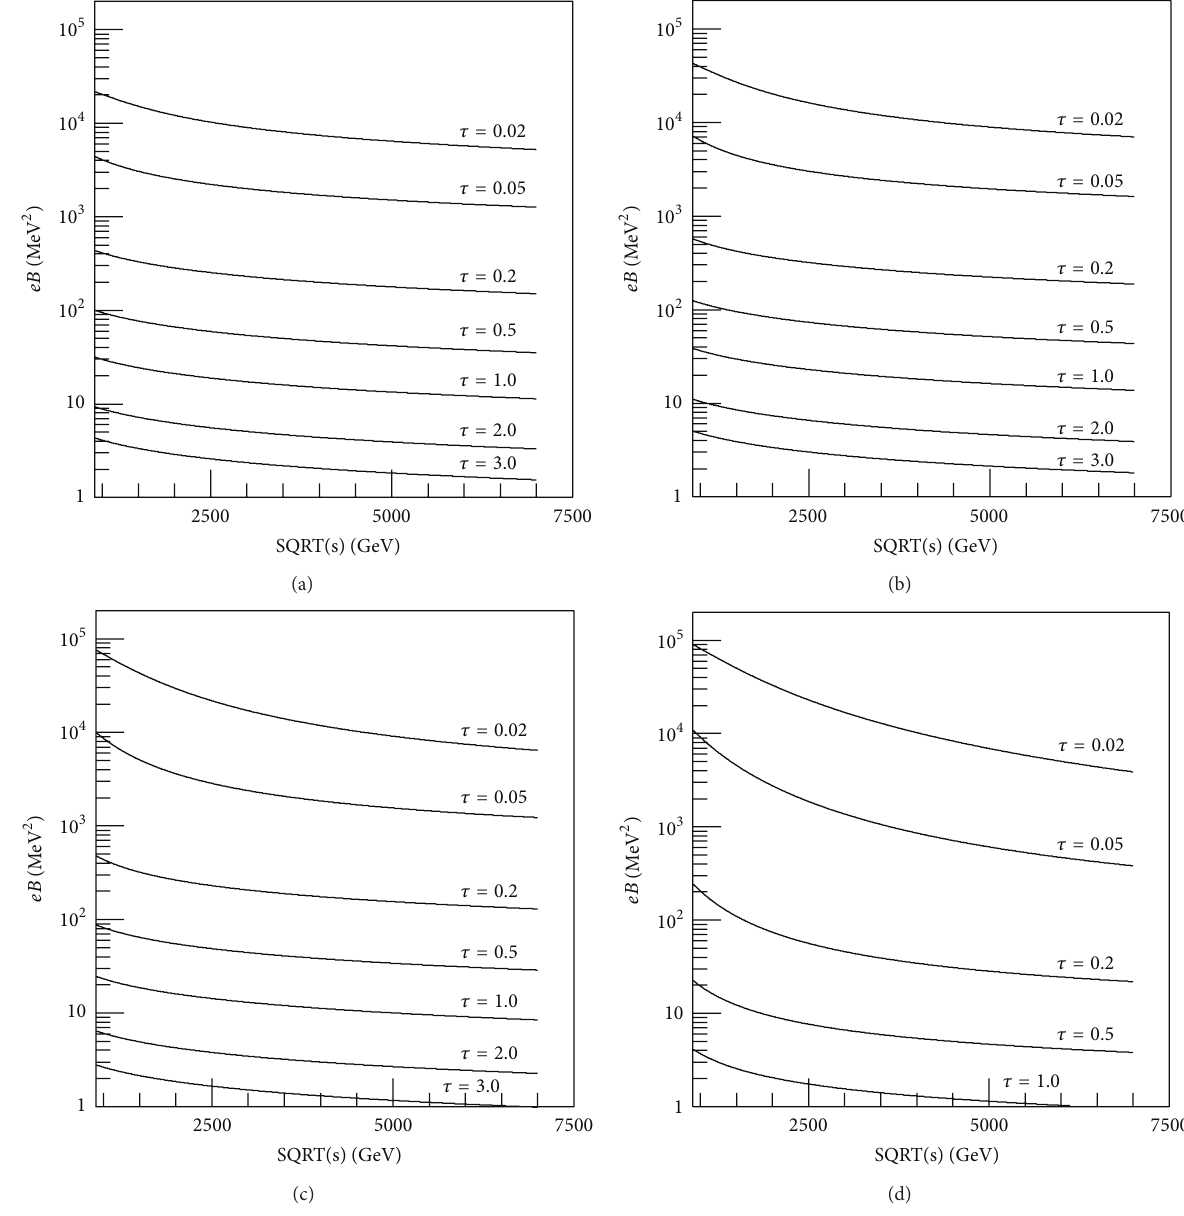
Figure 5: The dependencies of the magnetic field on collision energies of central mass system of LHC energy region of Pb-Pb collisions at different proper times at different impact parameters for 𝑏 = 2 fm (a), 𝑏 = 4 fm (b), 𝑏 = 8 fm (c), and 𝑏 = 12 fm (d), respectively.